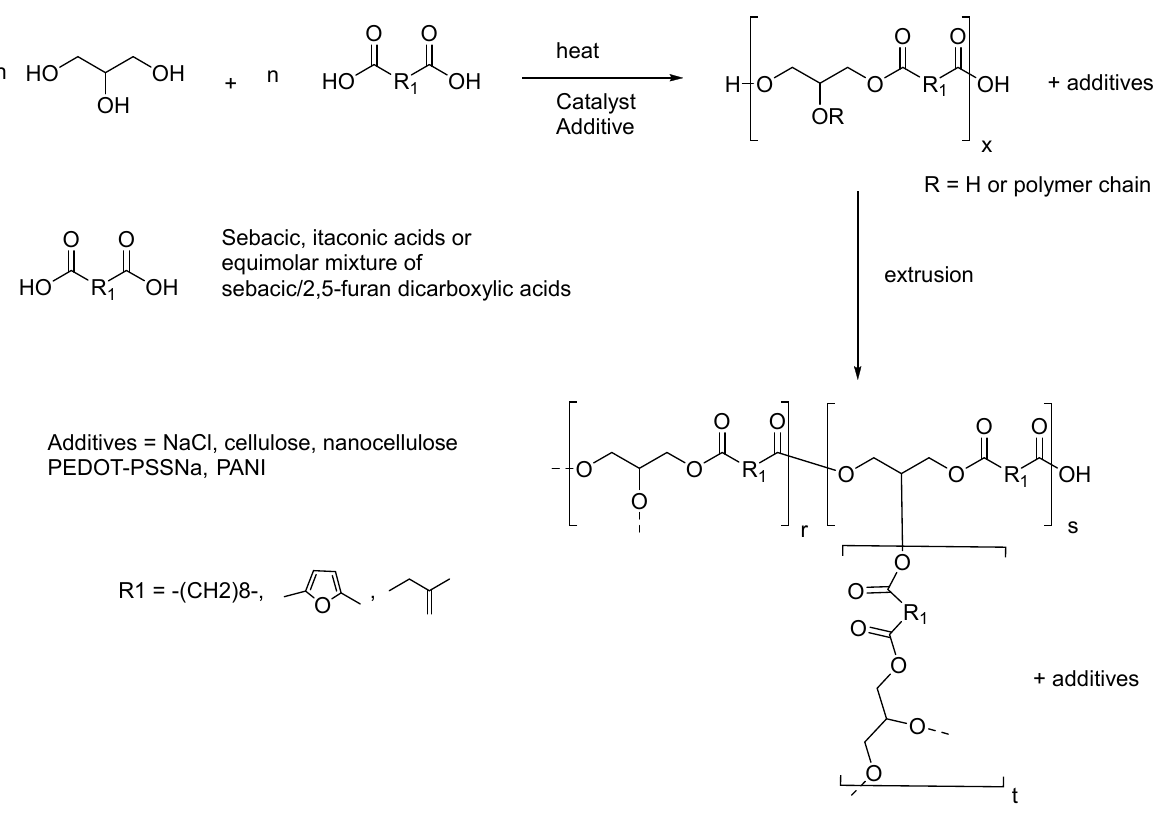
Figure 1. General procedure for the production of all composite elastomers.